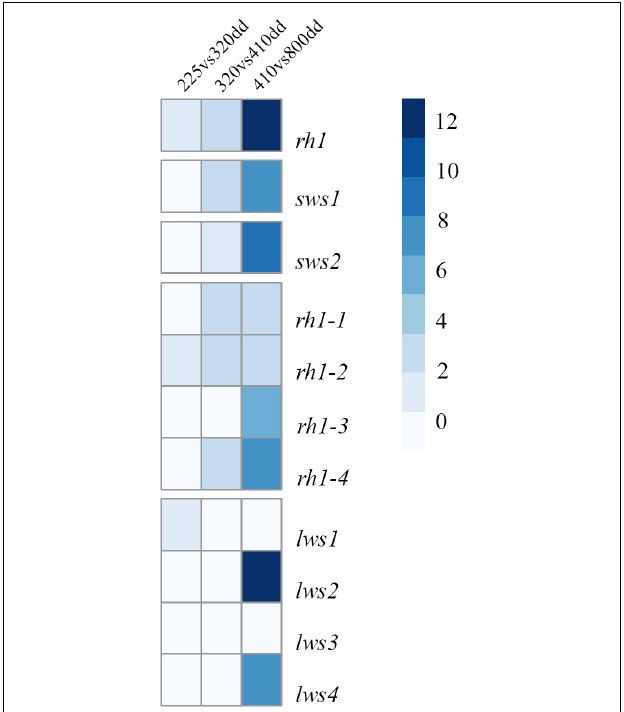
FIGURE 4 | A heatmap of expression levels for individual visual opsin genes in Atlantic salmon. The expression levels identified by RNA sequencing of whole embryos and alevins is presented by logfold2 change. The heatmap shows expression changes observed during development, revealing a significant shift in expression levels from 410 to 800 dd.